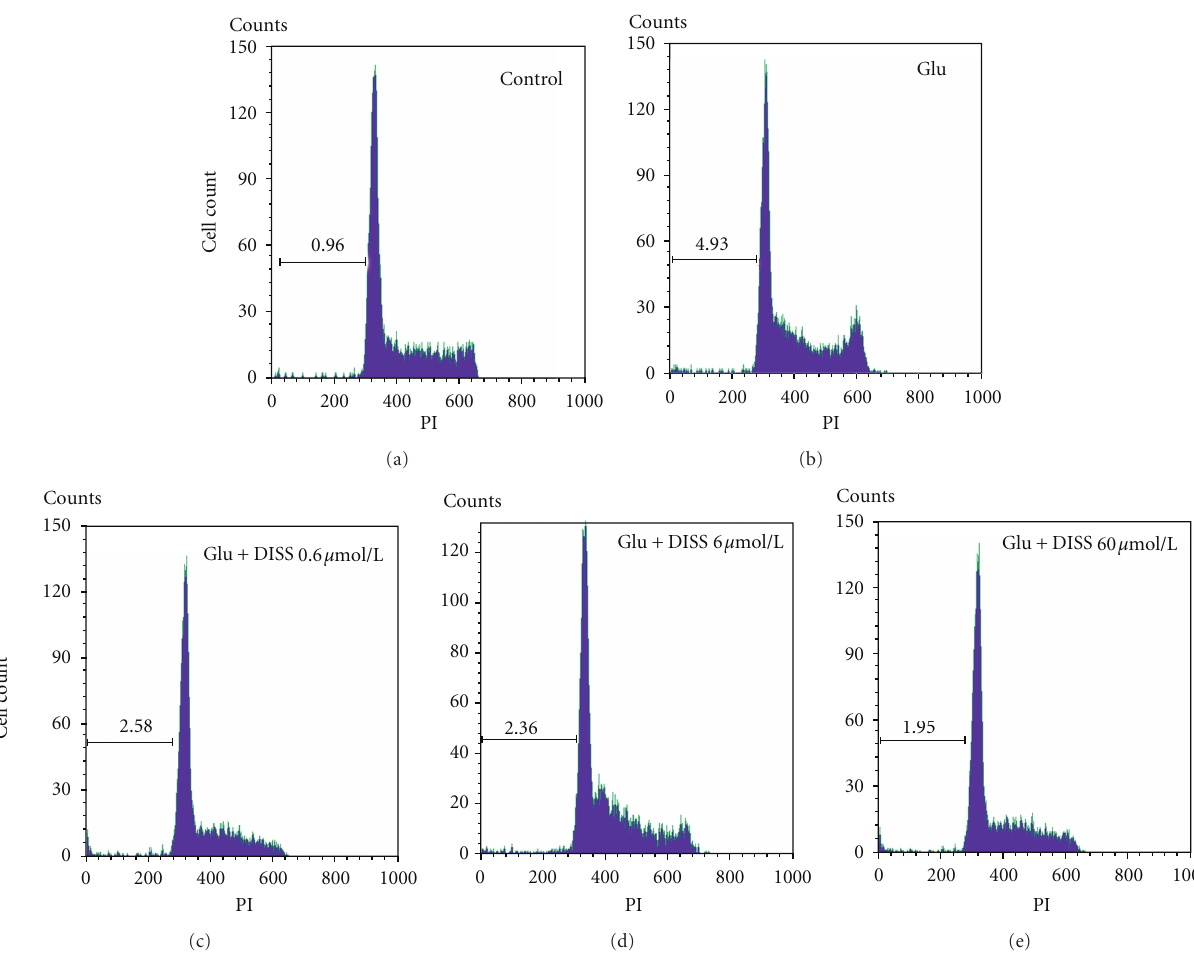
Figure 2: E ff ect of DISS against glutamate- (Glu-) induced neurotoxicity in cultured SH-SY5Y cells by flow cytometric DNA analysis. The sub-G1 peaks were determined by flow cytometry. (a) Control, (b) Glu alone, (c) Glu + 0.6 μ mol/L DISS, (d) Glu + 6 μ mol/L DISS, (e) Glu